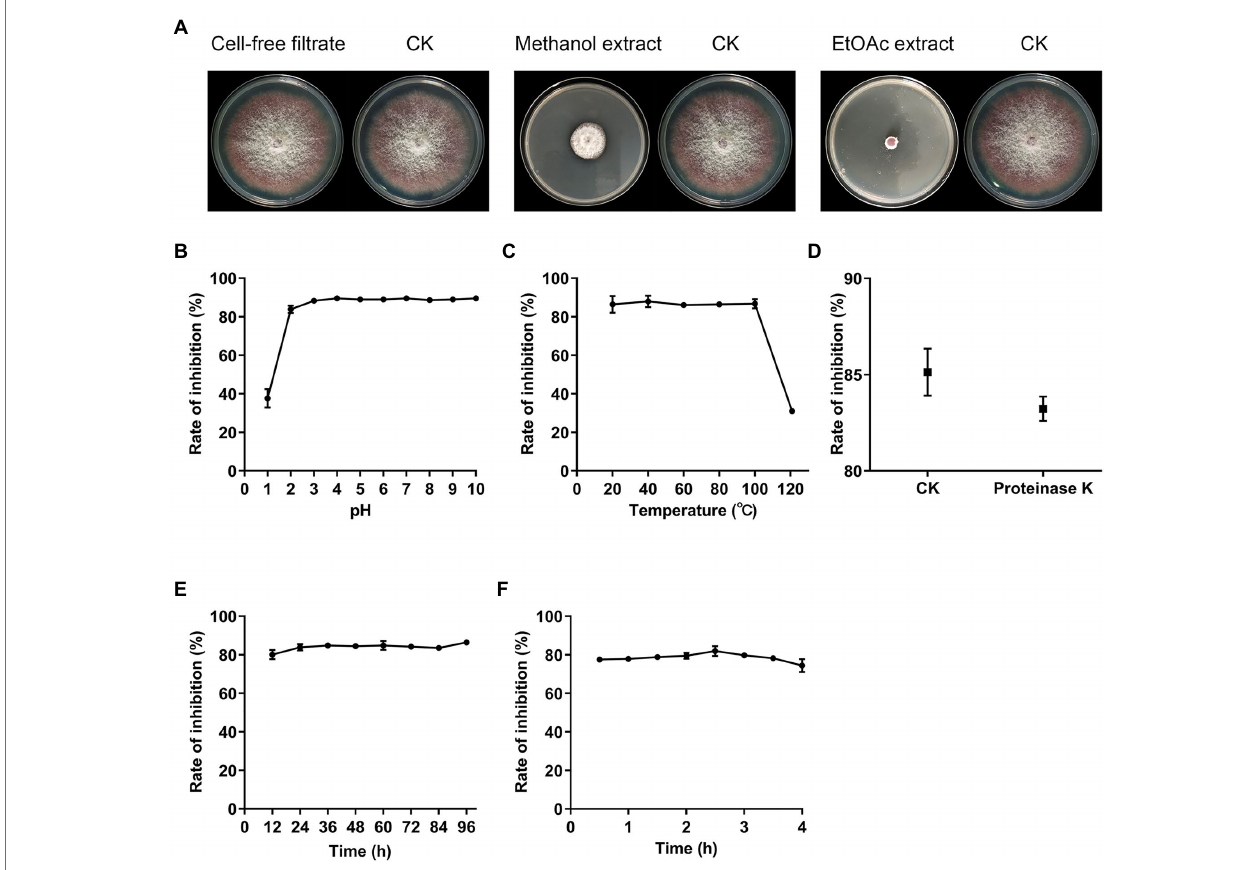
FIGURE 5 | The distribution and stability of active substances. (A) Antagonistic activities against Fov of secondary metabolites extracted from XN-04. (B) The effect of temperature (C) pH (D) proteinase K (E) lighting, and (F) UV on XN-04 active substances. Data are mean ± SD ( n =